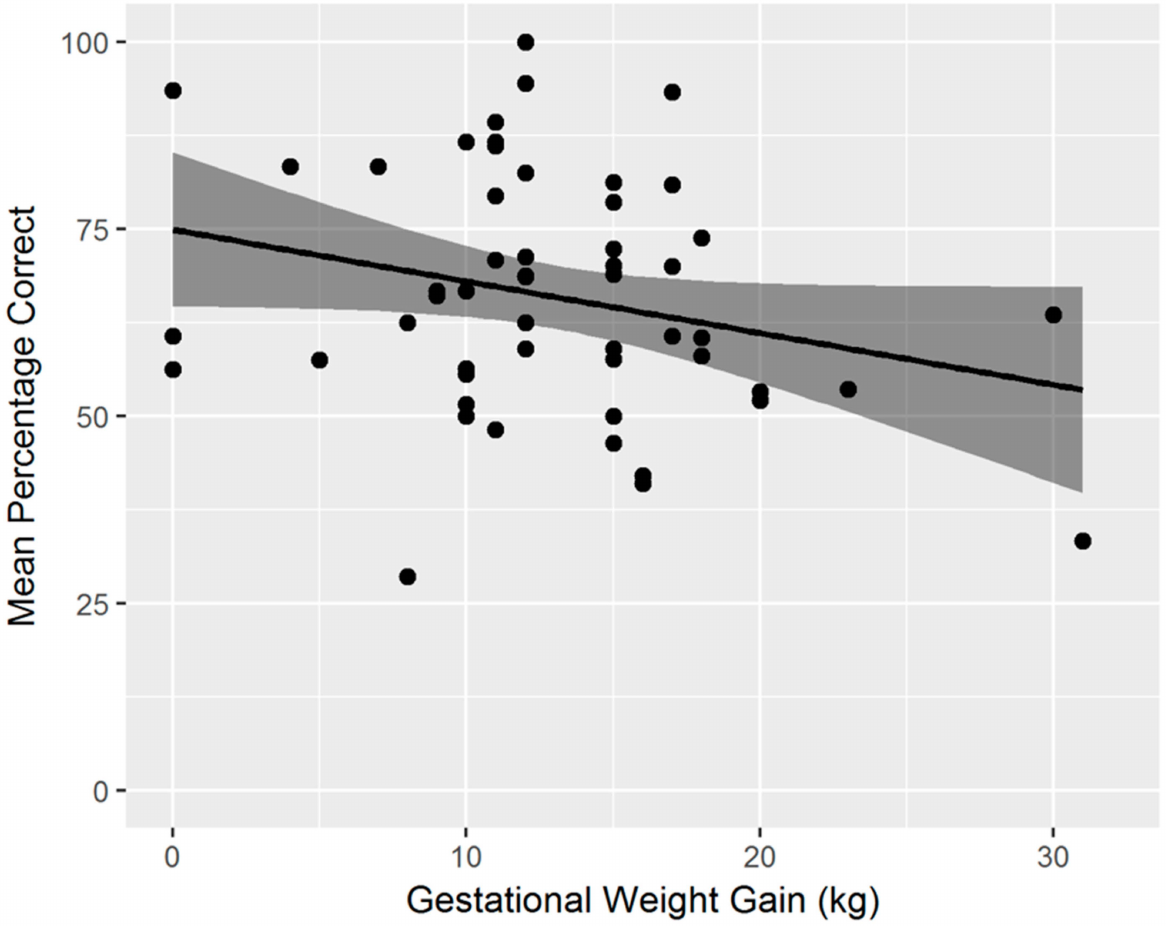
Figure 5. The relation between gestational weight gain and task performance (mean percentage